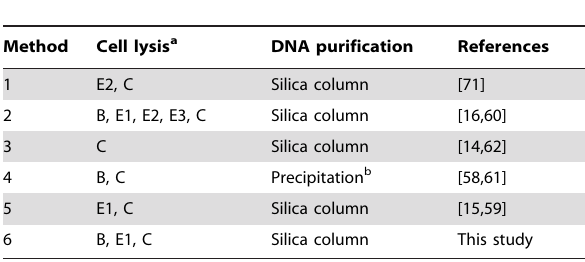
Table 1. Features of the six DNA extraction methods